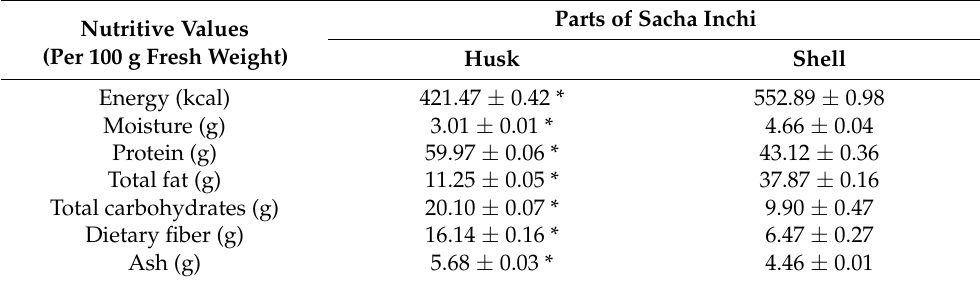
Table 2. Nutritive values in the husk and shell of sacha inchi.